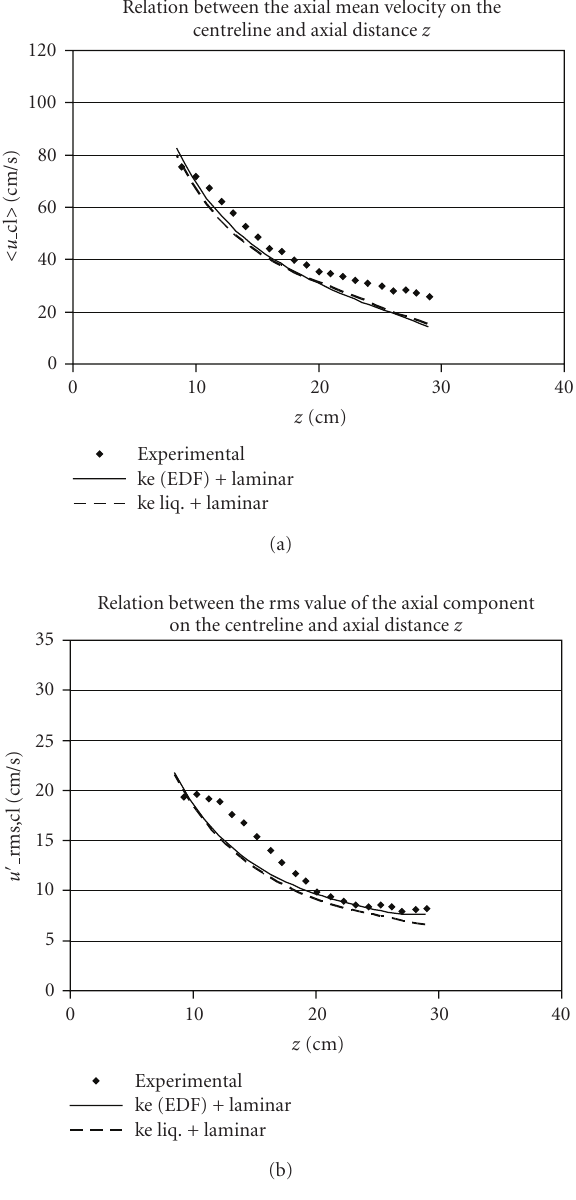
Figure 2: Calculated and measured values on the